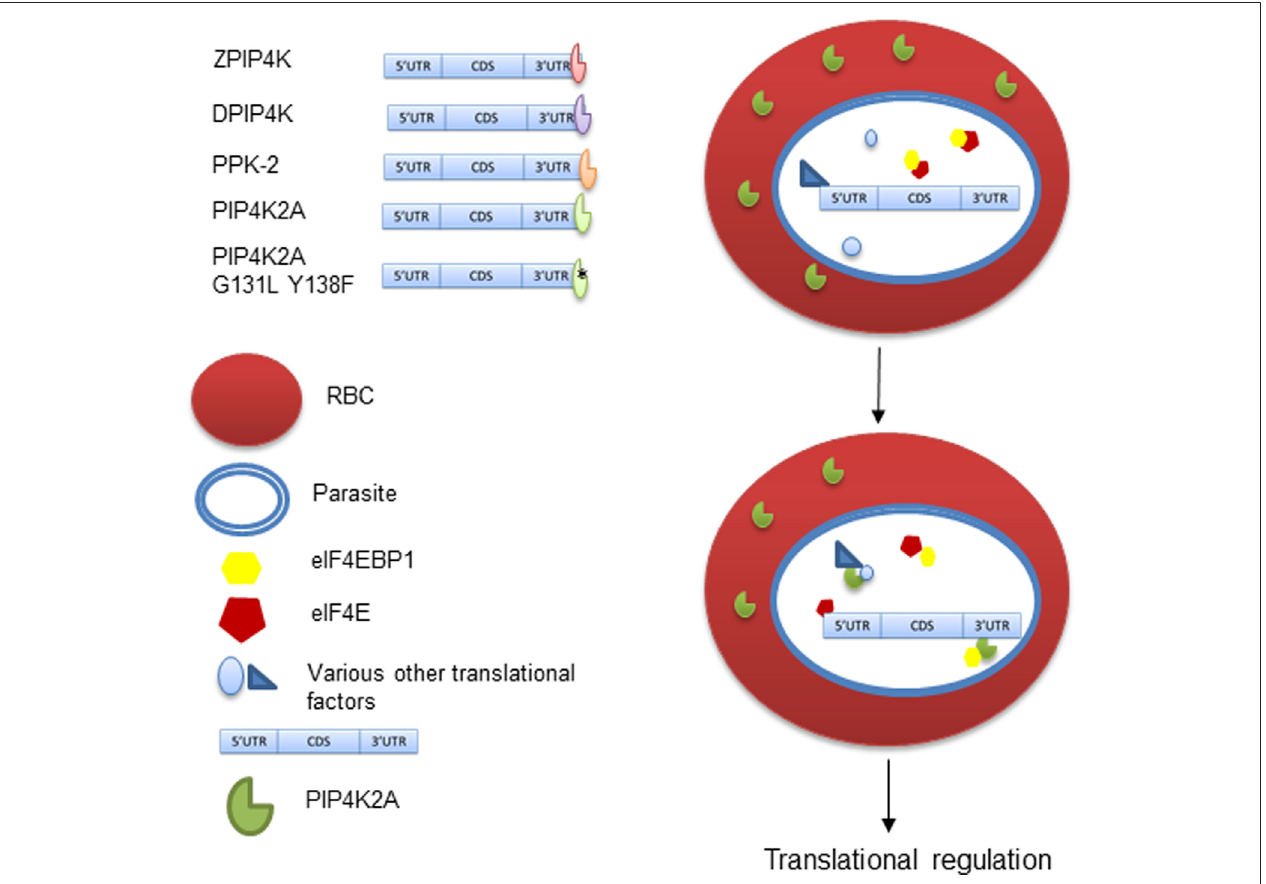
FIGURE5| RNAbindingactivityofPIP4Kanditsroleintranslationregulation.PIP4KfromdifferentspecieshaveRNAbindingactivityandbindto3 ′ UTRsequence. The RNA binding activity is independent of its kinase activity in PIP4K2A. PIP4K2A can speci fi cally interact and sequester eIF4EBP1, which is a known translational repressor. This in turn makes eIF4E available for mRNA cap binding and translation